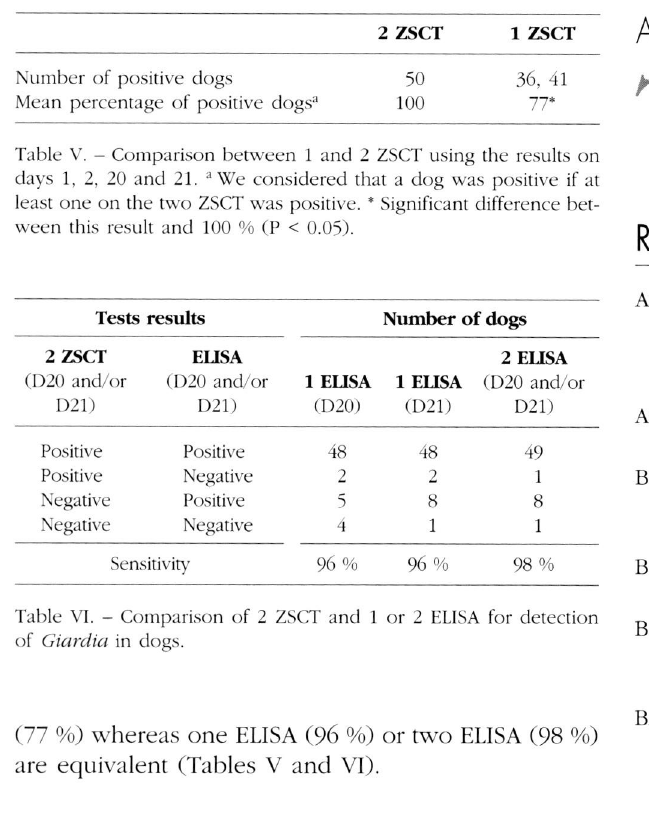
Table VI. - Comparison of 2 ZSCT and 1 or 2 ELISA for detection of Giardia in